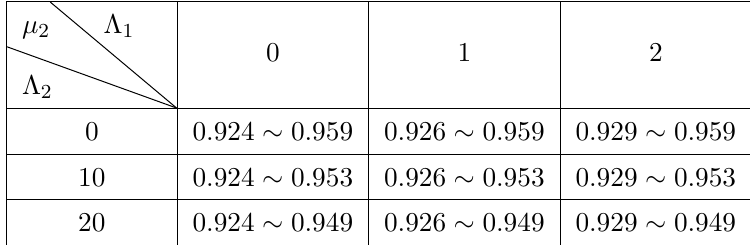
Figure 6 . Left : the mass M of the SIMBSs versus the angular momentum J for the synchronized frequency ω with m 2 = 1 , 2 , 3 , respectively. Right : the mass M of the SIMBSs versus the angular momentum J for the nonsynchronized frequency ω 2 with m 2 = 1 , 2 , 3 , respectively, and we demand the parameter ω 1 = 0 . 85 .